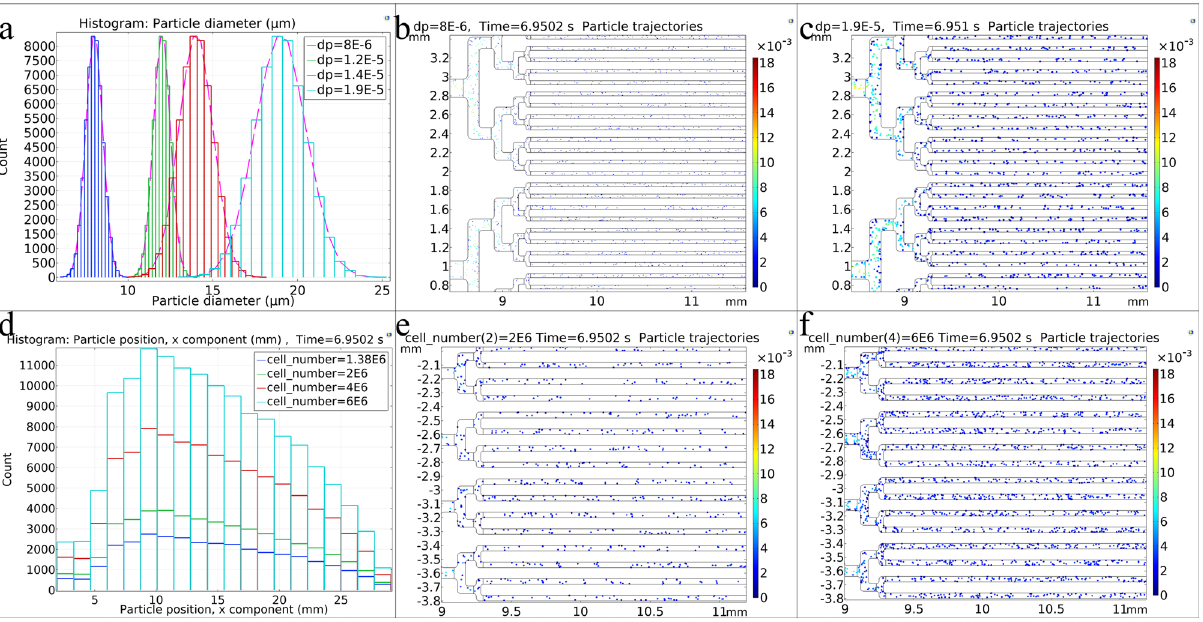
Figure 4. ( a ) Normal distribution of cell size for cells with average diameters of 8, 12, 14, and 19 μm in the microfluidic chip. ( b ) 8 μm diameter cell trajectories in the microfluidic chip. ( c ) 19 μm cell trajectories in the microfluidic chip. ( d ) Histogram of cell position along the microfluidic chip for different cell numbers in a constant volume of cell culture medium. ( e ) Cell trajectories in the microfluidic chip for a cell concentration of 2 × 10 6 cell/170 μl cell culture medium. ( f ) Cell trajectories in the microfluidic chip for a cell concentration of 6 × 10 6 cell/170 μl cell culture medium. All data were obtained for the microfluidic chip with 40 μm